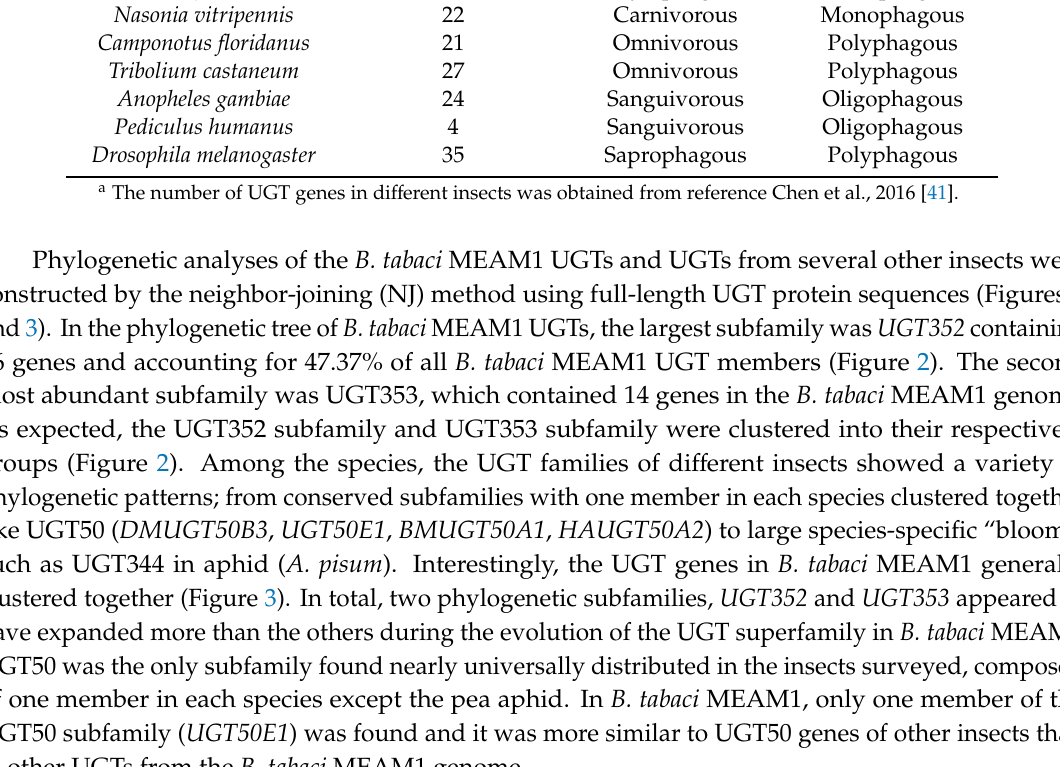
Table 1. The number of UDP-glucuronosyltransferases genes in di ff erent insects and mites. Species Number a Food Type Diet Breadth Bemisia tabaci 76 Phytophagous Polyphagous Tetranychus urticae 81 Phytophagous Polyphagous Acyrthosiphon pisum 72 Phytophagous Polyphagous Locusta migratoria 68 Phytophagous Polyphagous Helicoverpa armigera 42 Phytophagous Polyphagous Diaphorina citri 37 Phytophagous Oligophagous Rhodnius prolixus 16 Phytophagous Oligophagous Danaus plexippus 35 Phytophagous Oligophagous Apis mellifera 11 Phytophagous Oligophagous Nilaparvata lugens 20 Phytophagous Monophagous Bombyx mori 38 Phytophagous Monophagous Nasonia vitripennis 22 Carnivorous Monophagous Camponotus floridanus 21 Omnivorous Polyphagous Tribolium castaneum 27 Omnivorous Polyphagous Anopheles gambiae 24 Sanguivorous Oligophagous Pediculus humanus 4 Sanguivorous Oligophagous Drosophila melanogaster 35 Saprophagous